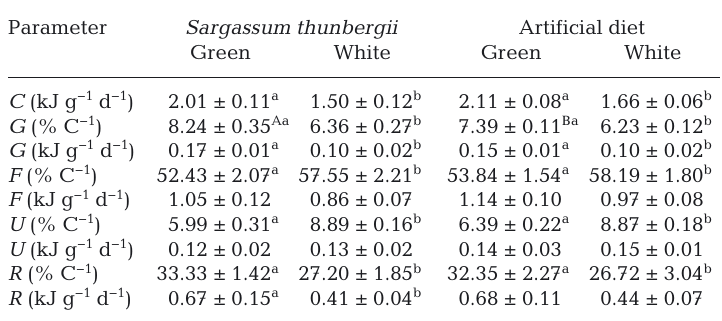
Table 5. Energy allocation of green and white sea cucumber fed the experi- mental diet. C : energy consumed; G : energy for growth; F : energy of feces produced; U : energy lost through ammonia excretion; R : energy lost through respiration. Different superscript capital letters within the same row indicate significant differences between diets for the same color morph (p < 0.05); dif- ferent lowercase letters mean significant differences between color morphs fed the same diet (p <